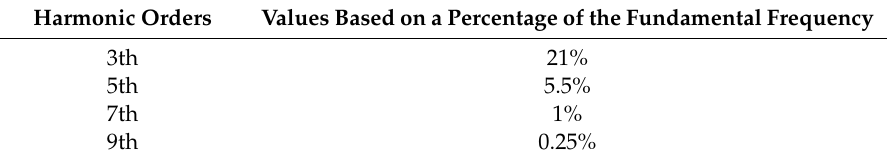
Figure 30. FFT analysis diagram for injected current via the IARC method. Table 3. Current signals